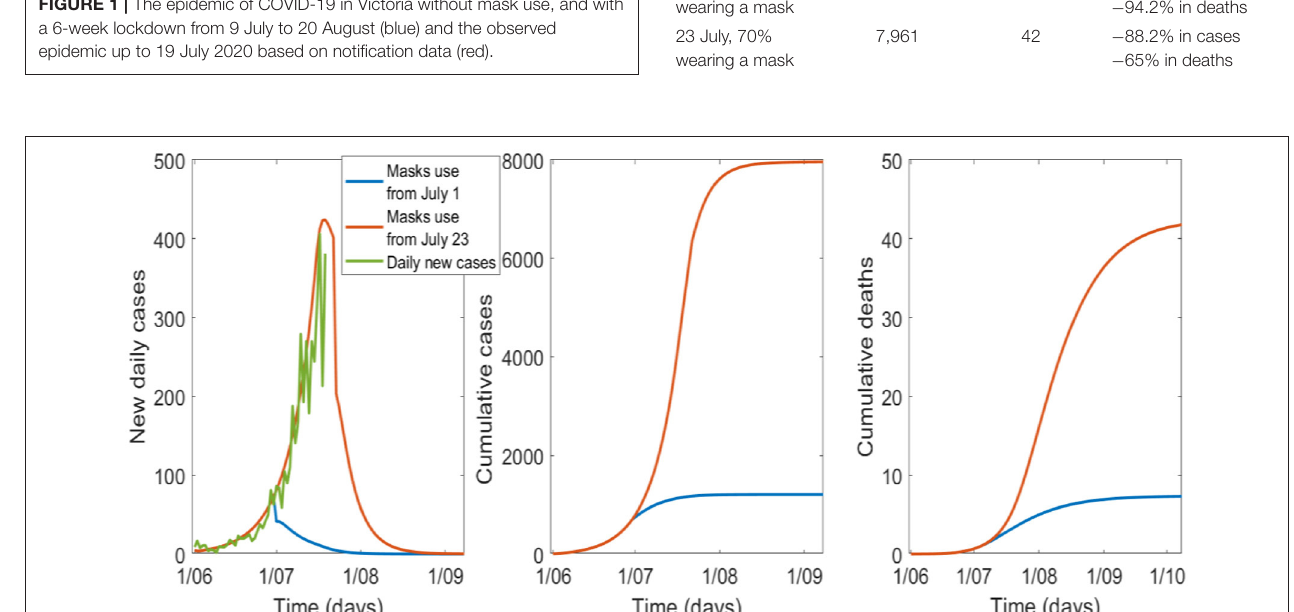
Frontiers in Public Health |